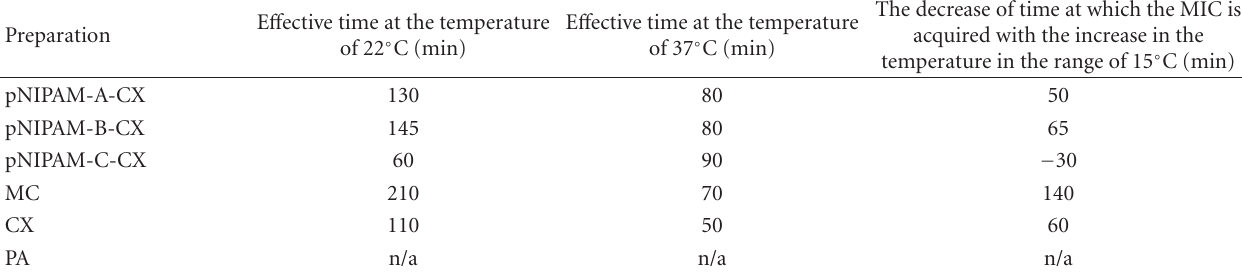
Table 4: Assessed e ff ective times ∗